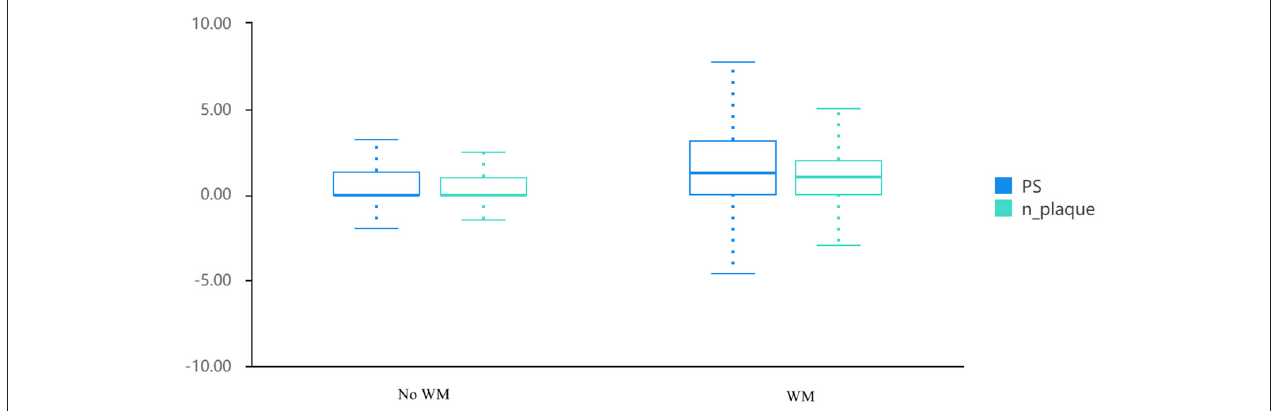
FIGURE 1 | Distribution of PS and PN in patients with white matter hyperintensity and controls. PS, plaque score; PN, plaque number.